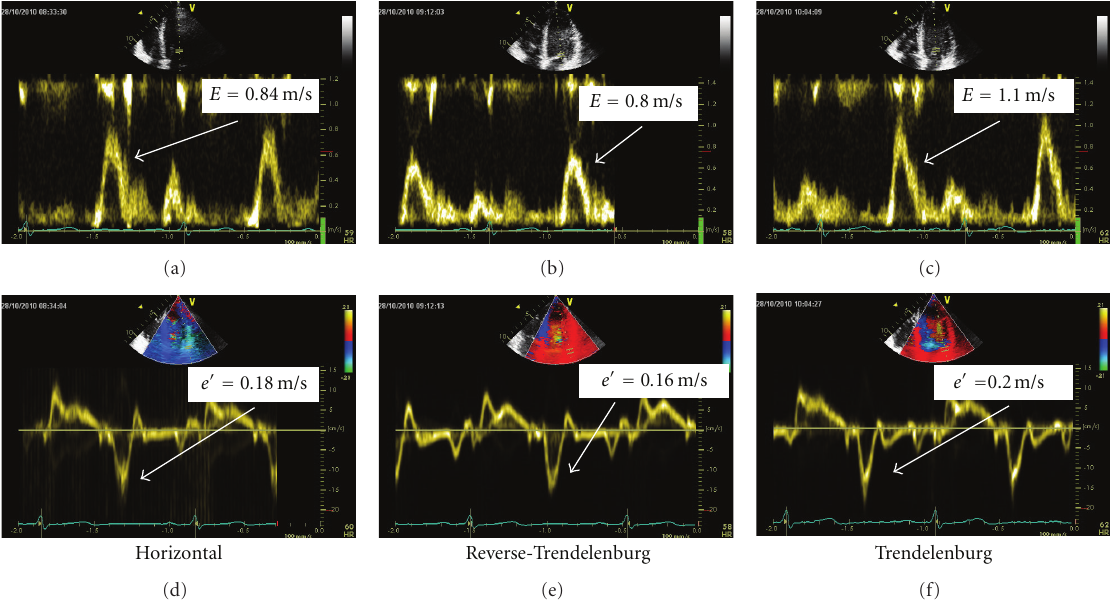
Figure 1: Examples of echocardiographic indices of diastolic function in the horizontal position, reverse-Trendelenburg position, and the Trendelenburg position during positive pressure ventilation. e (cid:2) : peak early diastolic velocity of the lateral mitral annulus, obtained with tissue Doppler. E : peak early transmitral blood